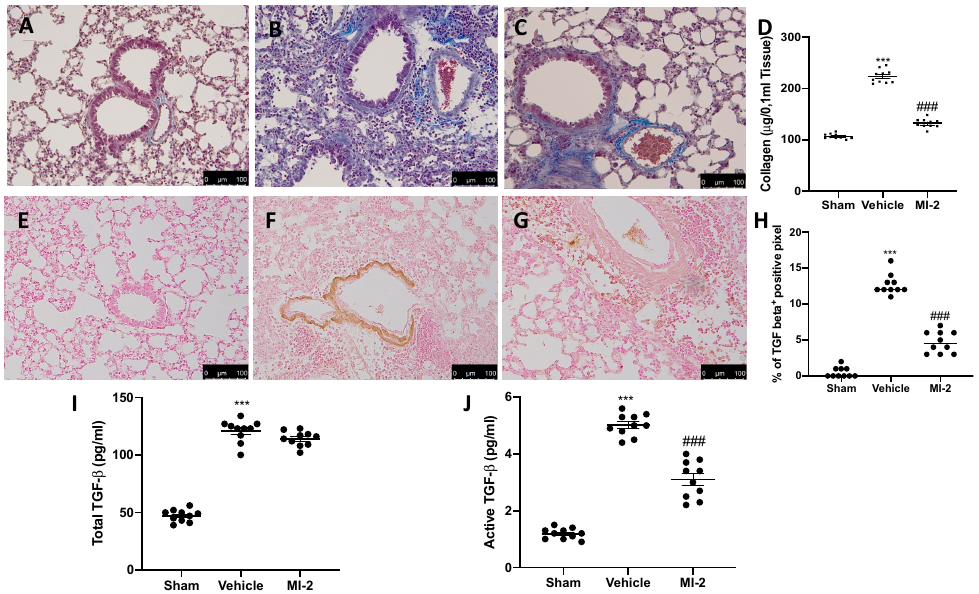
Figure 6. Effect of MI-2 on collagen deposition and TGF- β expression : Masson trichrome staining: sham ( A ), vehicle ( B ), MI-2 ( C ), sircol soluble collagen assay ( D ), immunohistochemical analysis of TGF-1 β expression: sham ( E ), vehicle ( F ), MI-2 ( G ), % of positive pixels ( H ), concentration of total TGF- β ( I ) and active TGF- β ( J ) in BAL fluids. For each analysis, n = 10 animals from each group were employed.